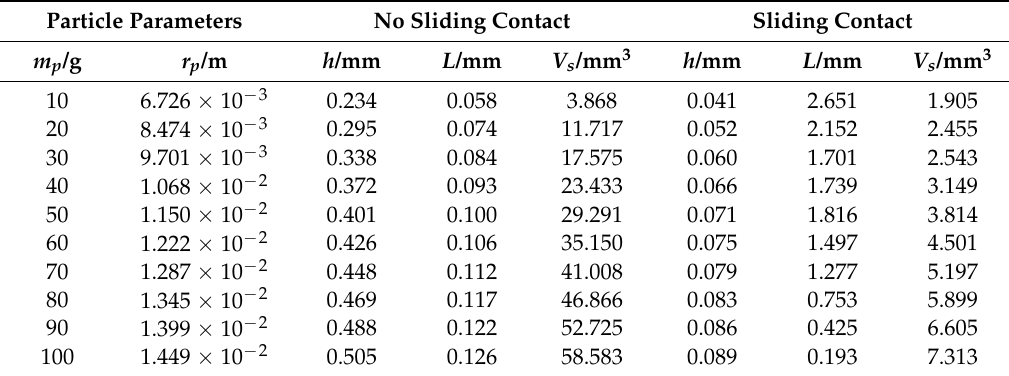
Table 3. Geometric size of impact craters with sliding contact or no sliding